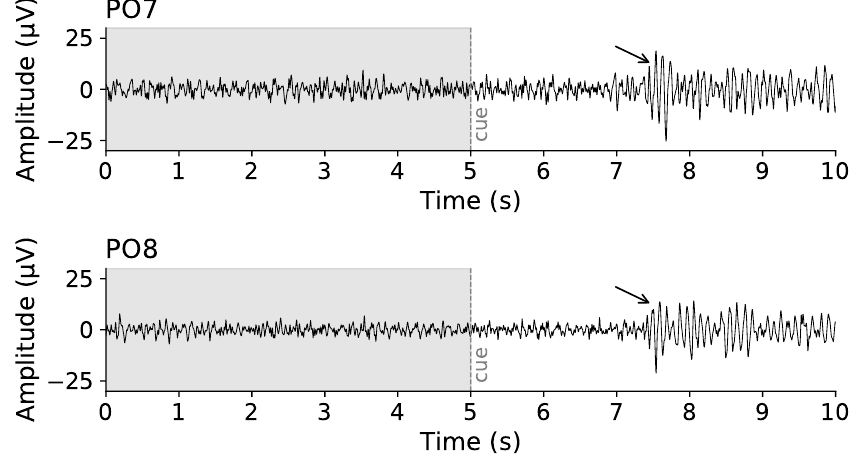
Figure 4. Alpha activity recorded during training by electrodes in positions PO7 and PO8. The shaded epoch corresponds to the timespan the subject had their eyes open; the clear epoch relates to the moment the subject closed their eyes after the auditory cue at the 10 s mark. An increase in amplitude can be seen approximately two seconds after the